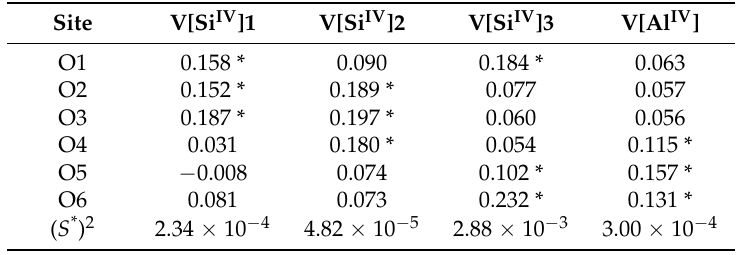
Figure 6. The local bond distances and angles of five configurations after substitution. Table 3. The shift of bridging oxygens after vanadium substitution (Å).